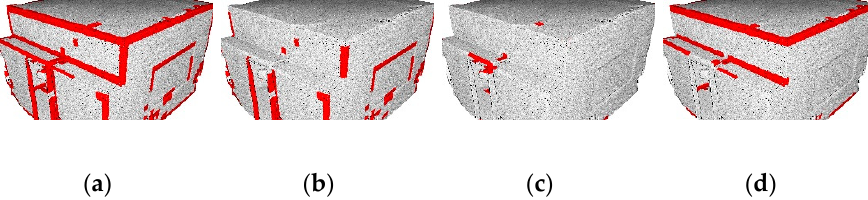
Figure 9: S3DIS points within categorized voxels. ( a ) Full transition voxels, ( b ) vertical group of points, ( c ) horizontal group of points, and ( d ) mixed group of points.